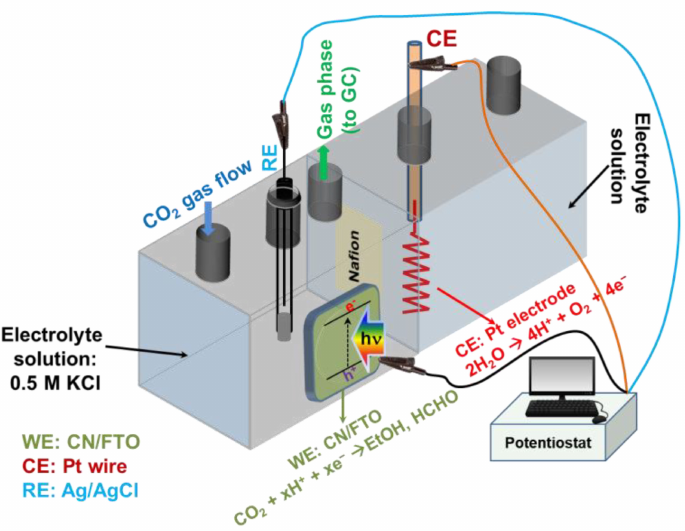
Figure 10. A schematic representation of the photoelectrochemical cell for CO 2 reduction. WE: working electrode; CE: counter electrode, coiled Pt wire; RE: reference electrode, Ag/AgCl with 3.0 M NaCl.